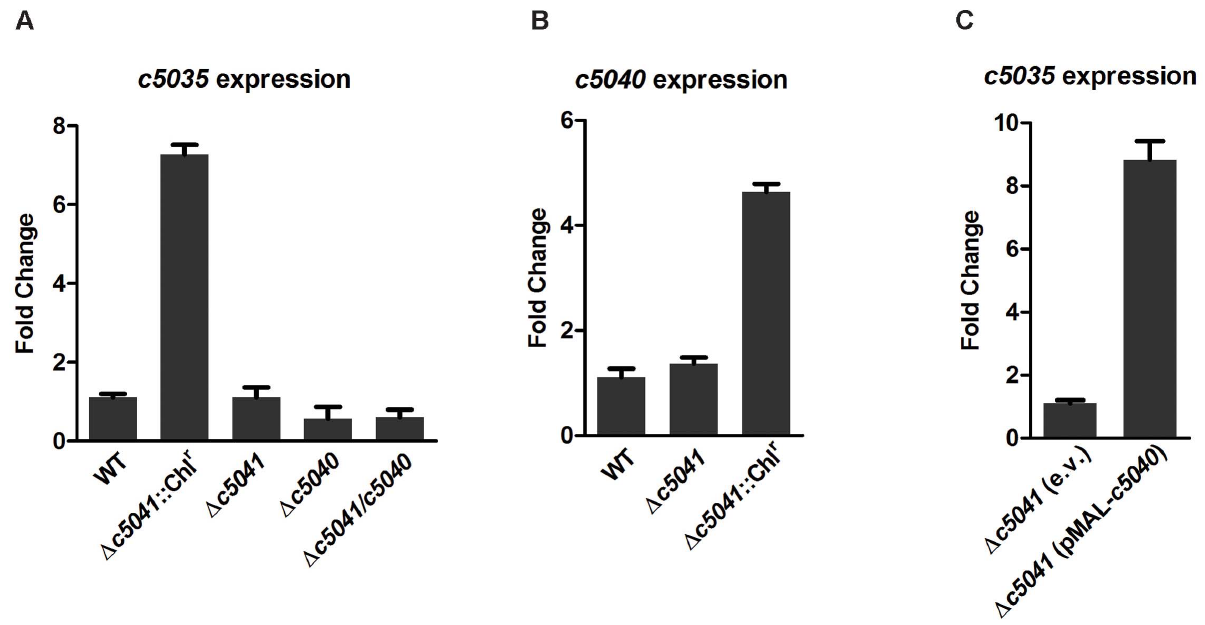
Figure 3. Overexpression of c5040 upregulated c5035 expression independent of the natural stimulus. Bacteria were grown in human urine under aerobic conditions before being subjected to RNA extraction. qRT-PCR expression values are means plus standard deviations (error bars) of three independent experiments. (A) c5035 expression in various TCS mutants compared to WT. (B) c5040 expression in D c5041 and D c5041 ::Chl r mutants compared to WT. (C) c5035 expression in D c5041 mutant carrying the pMAL plasmid with c5040 under the control of P tac promoter as compared to D c5041 mutant carrying the empty vector (e.v.). IPTG is present at 1 mM for induction.